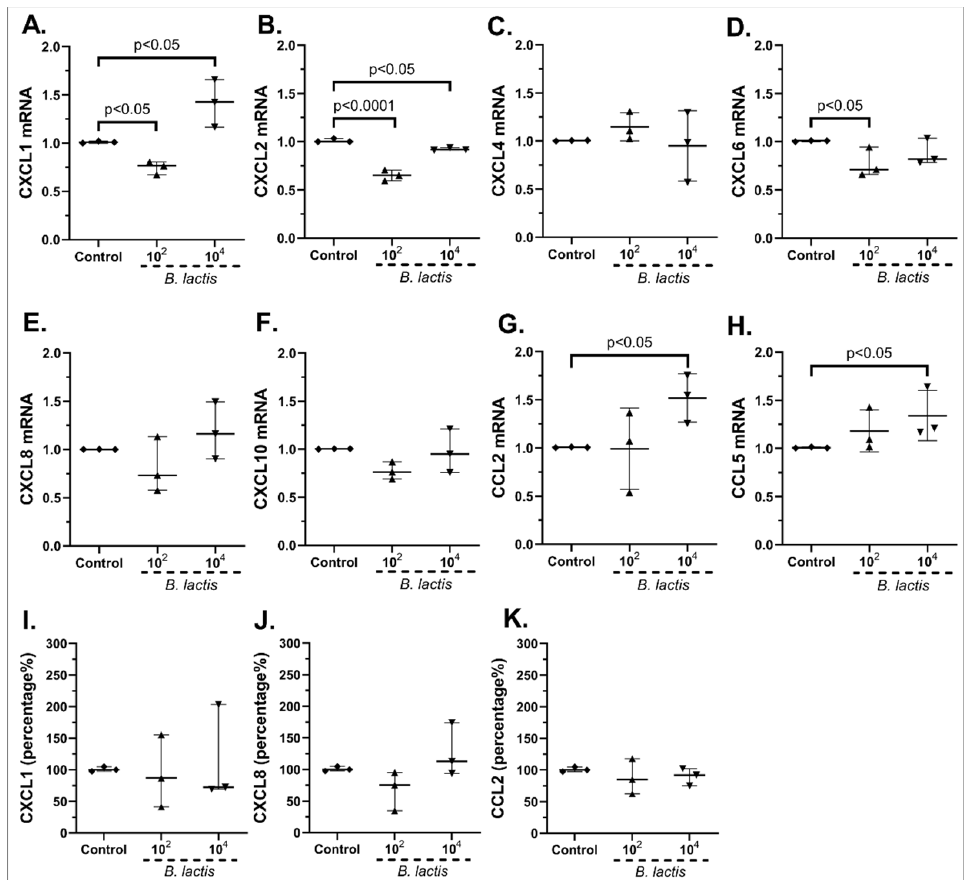
Figure 5. cSEMF mRNA expression of CXCL1 ( A ), CXCL2 ( B ), CXCL4 ( C ), CXCL6 ( D ), CXCL8 ( E ), CXCL10 ( F ), CCL2 ( G ) and CCL5 ( H ) and protein levels of CXCL1 ( I ), CXCL8 ( J ) and CCL2 ( K ) after stimulation with Bifidobacterium lactis. Results are presented as median with interquartile range. N = 3.